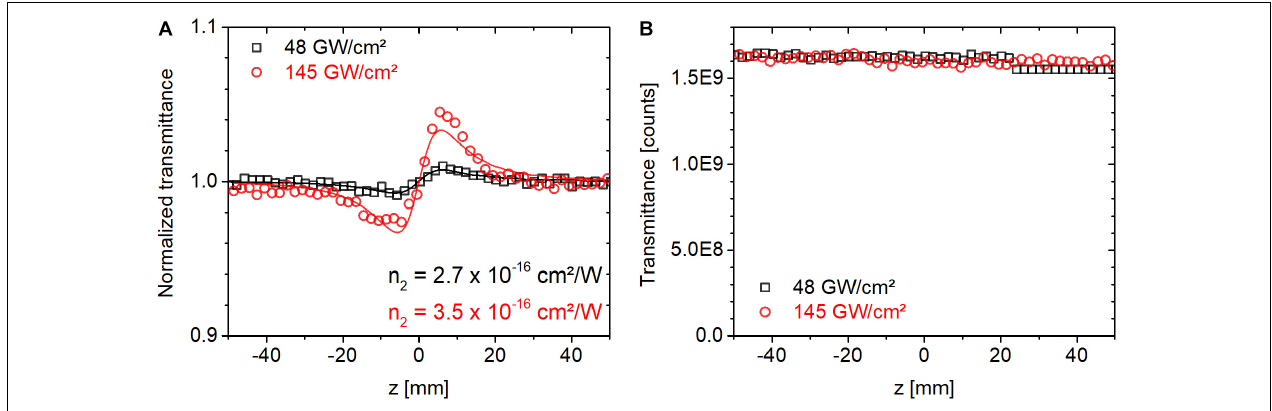
FIGURE 2 | (A) Closed and (B) open-aperture Z-scan traces measured for a BK7 substrate using 514-nm ultrafast laser pulses at a repetition rate of 1 kHz at peak on-axis intensities of 48 and 145 GW/cm 2